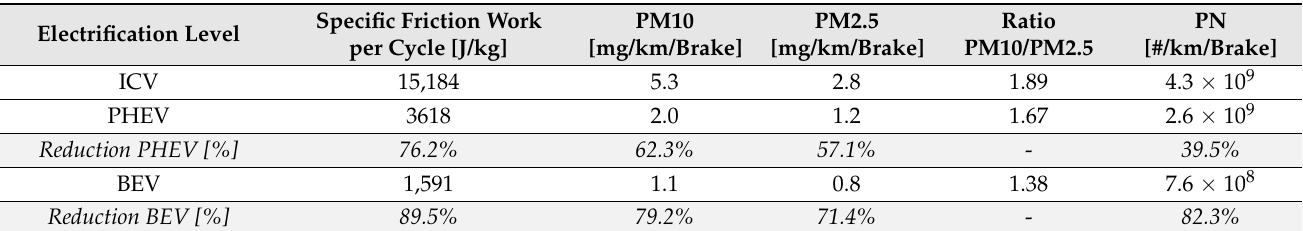
Table 10. Friction work and emission factors in comparison between ICV, PHEV, and BEV mode. Electrification Level